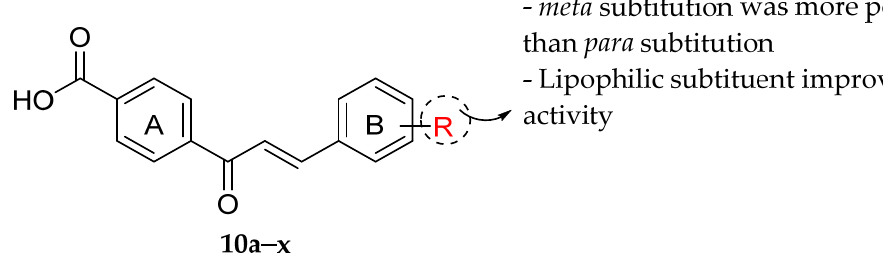
Figure 28. SAR of carboxylated chalcones for antibacterial activities [97].